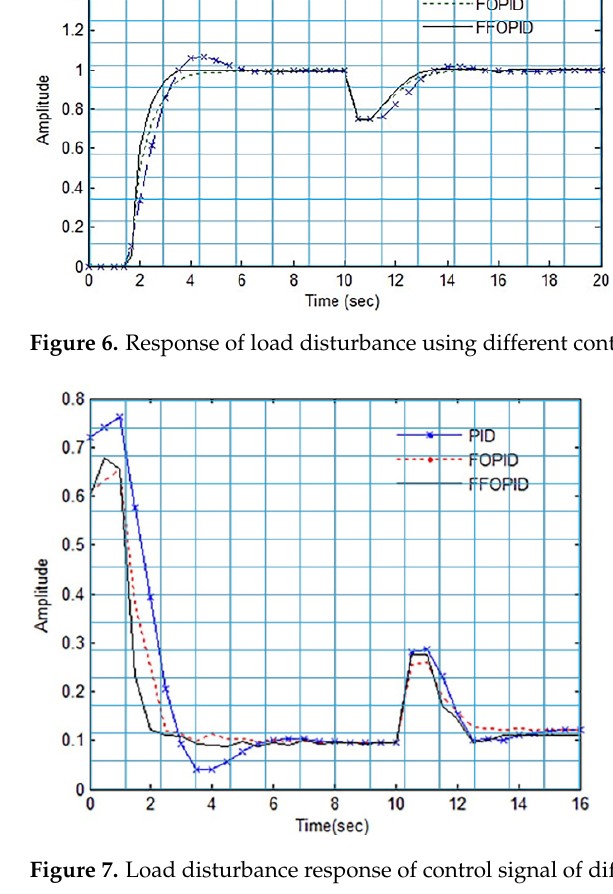
Figure 7. Load disturbance response of control signal of different controllers.